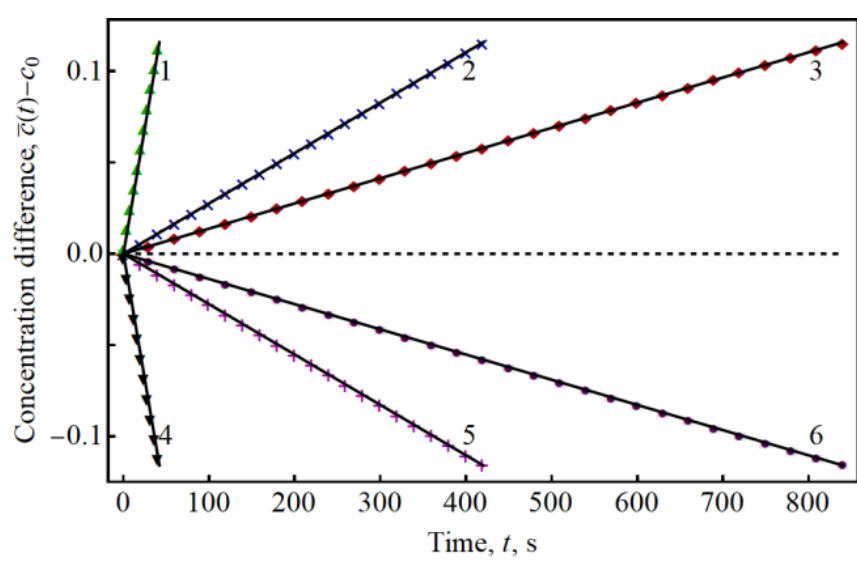
Figure 3. Kinetics of average concentration at the single-phase stage of insertion (1–3) and extraction (4–6) processes. Points are the solution of the CH equation, lines correspond to the linear dependence (3). time interval and the particle passes to double-phase pattern (see lines 3 and 4 in Figure 2a–f). At